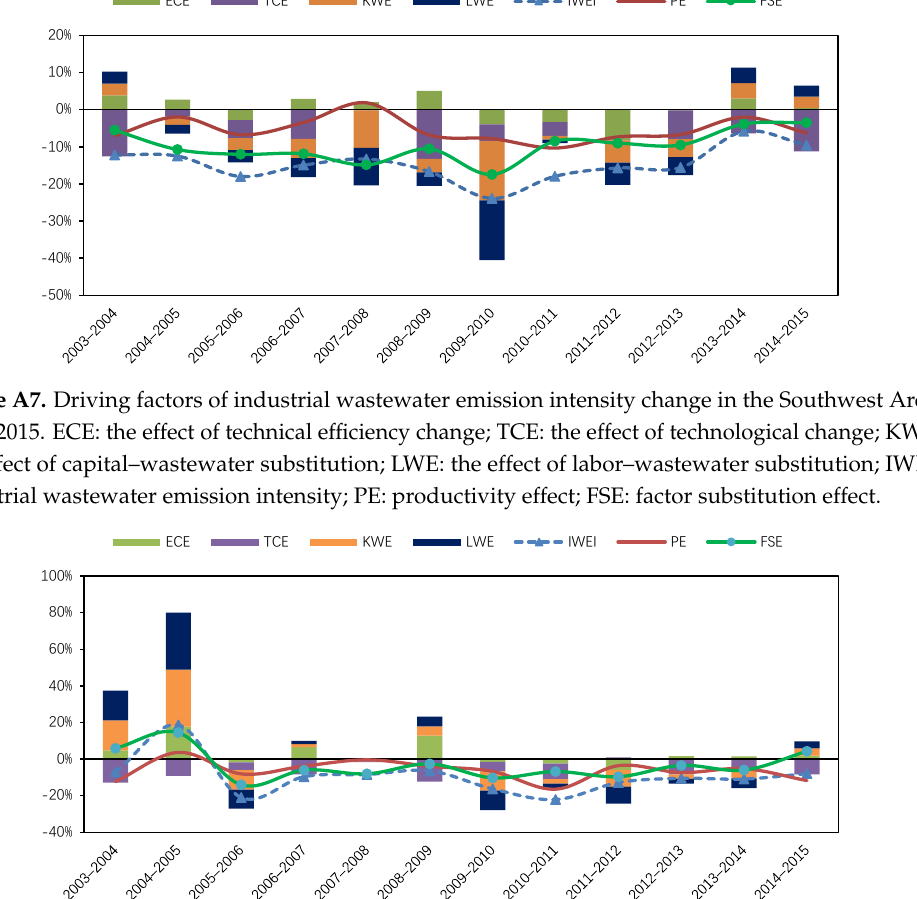
Figure A8. Driving factors of industrial wastewater emission intensity change in the Great Northwest Area, 2003–2015. ECE: the effect from technical efficiency change; TCE: the effect of technological change; KWE: the effect of capital – wastewater substitution; LWE: the effect of labor – wastewater substitution; IWEI: industrial wastewater emission intensity; PE: productivity effect; FSE: factor substitution effect.